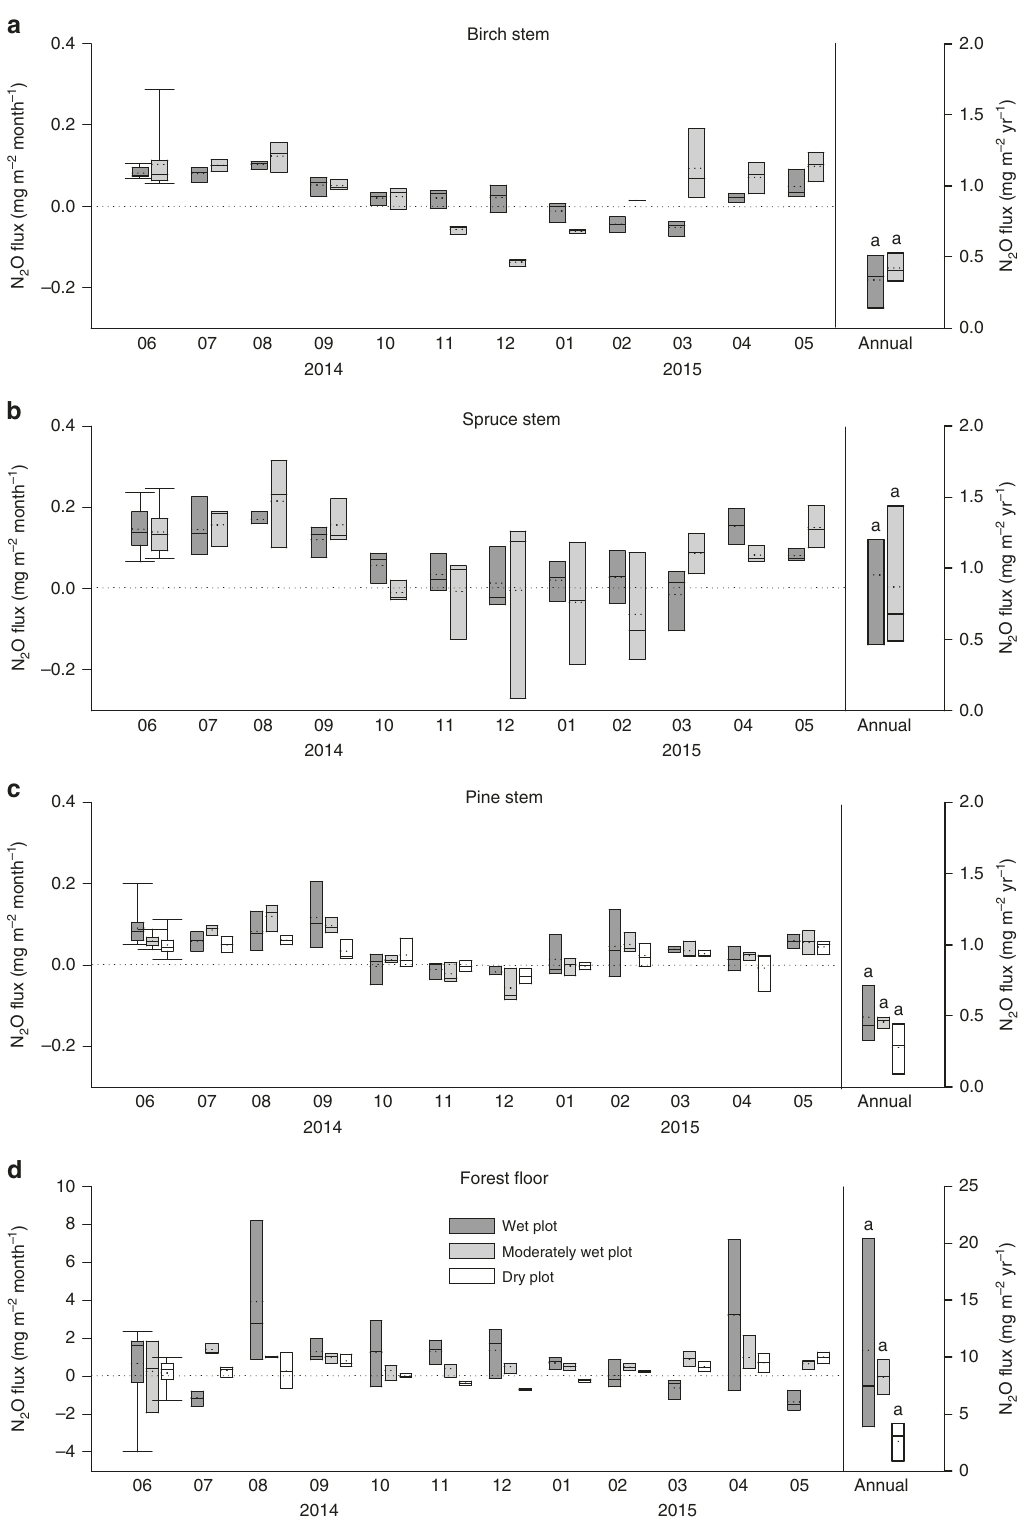
Fig. 1 Stem and forest fl oor N 2 O fl uxes. Seasonal courses of monthly N 2 O fl uxes (mg m − 2 month − 1 ) and total annual N 2 O fl uxes (mgm − 2 yr − 1 ) from stems of birch ( a ), spruce ( b ), and pine ( c ), and from forest fl oor ( d ) measured from June 2014 to May 2015. Positive fl uxes indicate N 2 O emission, negative fl uxes N 2 O uptake. The solid line within each box marks the median value, broken line the mean, box boundaries the 25th and 75th percentiles, and whiskers the 10th and 90th percentiles. Statistically signi fi cant differences among annual fl uxes at p <0.05 are indicated by different letters above bars. Mean annual volumetric water contents (±standard error) of the plots were as follow: wet plot, 0.81±0.02m 3 m − 3 ; moderately wet plot, 0.40±0.02m 3 m − 3 ; and dry plot, 0.21±0.01m 3 m − 3 . The dry plot did not have spruce or birch trees. Stem fl uxes were measured from three trees per species at each plot ( n = 3). Forest fl oor fl uxes were measured at three positions at the wet and moderately wet plots ( n = 3) and at six positions at the dry plot ( n = 6). Annual fl uxes were calculated as the sums of 12 monthly fl uxes NATURE COMMUNICATIONS| (2019) 10:4989